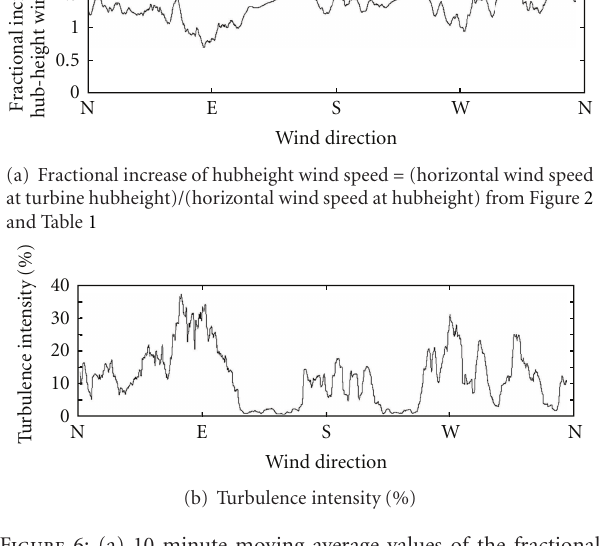
Figure 6: (a) 10-minute moving average values of the fractional increase of hubheight wind speed, and (b) corresponding turbu- lence intensity. Here, the results from Turbine no. 1 are given as an